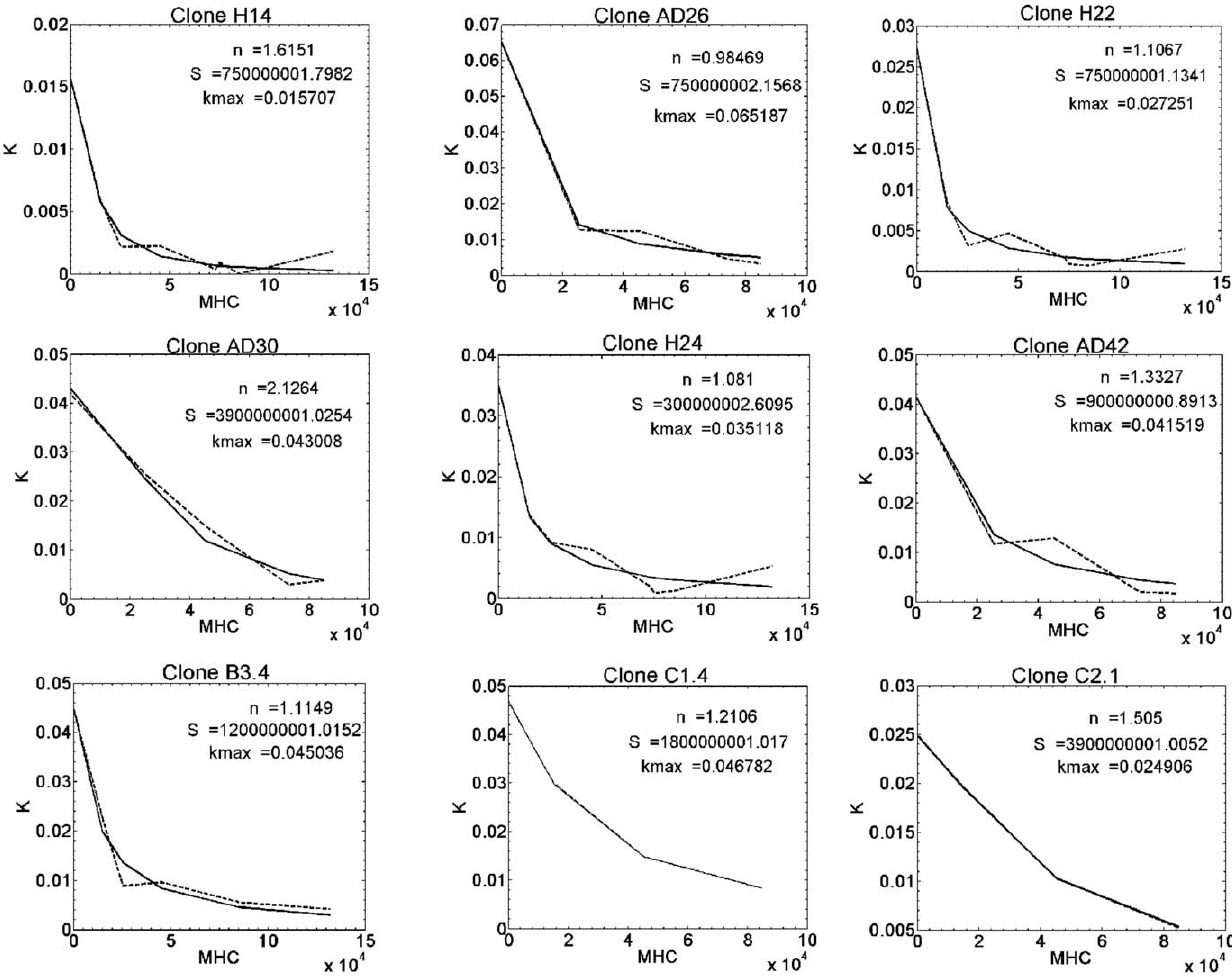
Figure 4. Sample fitting graphs. The dependence of target cell lysis on target cell MHC expression level. Dashed lines: k values calculated from experimental lysis data based on Figure S1D. Solid lines: the best fit of model results to the data (in clones C1.4 and C2.1 these lines are masked by the dashed lines). The values of n , S and k max that yielded best fit for each clone modeled are indicated on the figures. The parameter value ranges used in these runs were: n was 0.25–3.00, varied in 23 steps of 0.125; S was 0–5*10 9 , varied in 101 steps of 5*10 7 ; k max was 0.01–0.21, varied in 21 steps of 0.01.